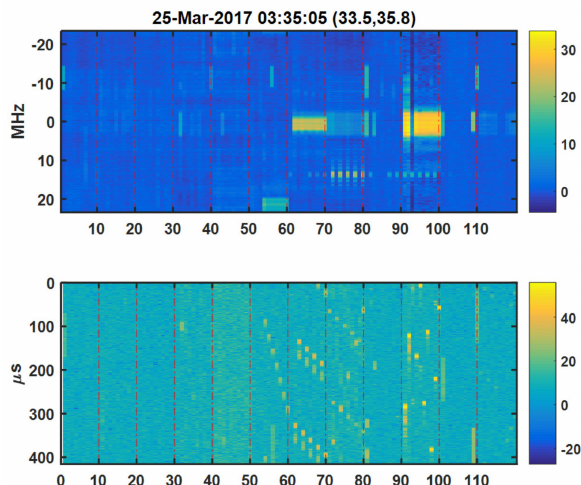
Figure 7. Example of high-power RFI in the spectrogram ( top ); and in the time-along track domain ( bottom ). Color scales are in dB. Horizontal axis is in number of rank pulses that is 10 for